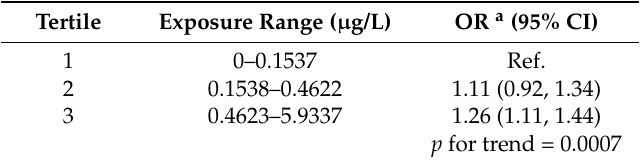
Table 5. Association a between term low birth weight births and tertiles of gestational atrazine exposure among live singleton births in AMP communities ( n = 22) in Ohio, 2006–2008.